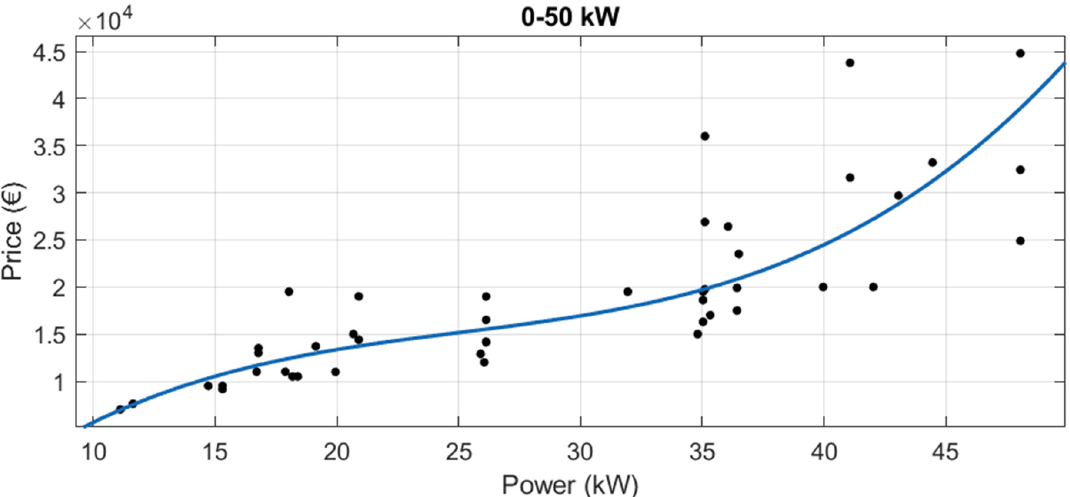
Figure 12. Price vs. power for new tractors from 0 to 50 kW.